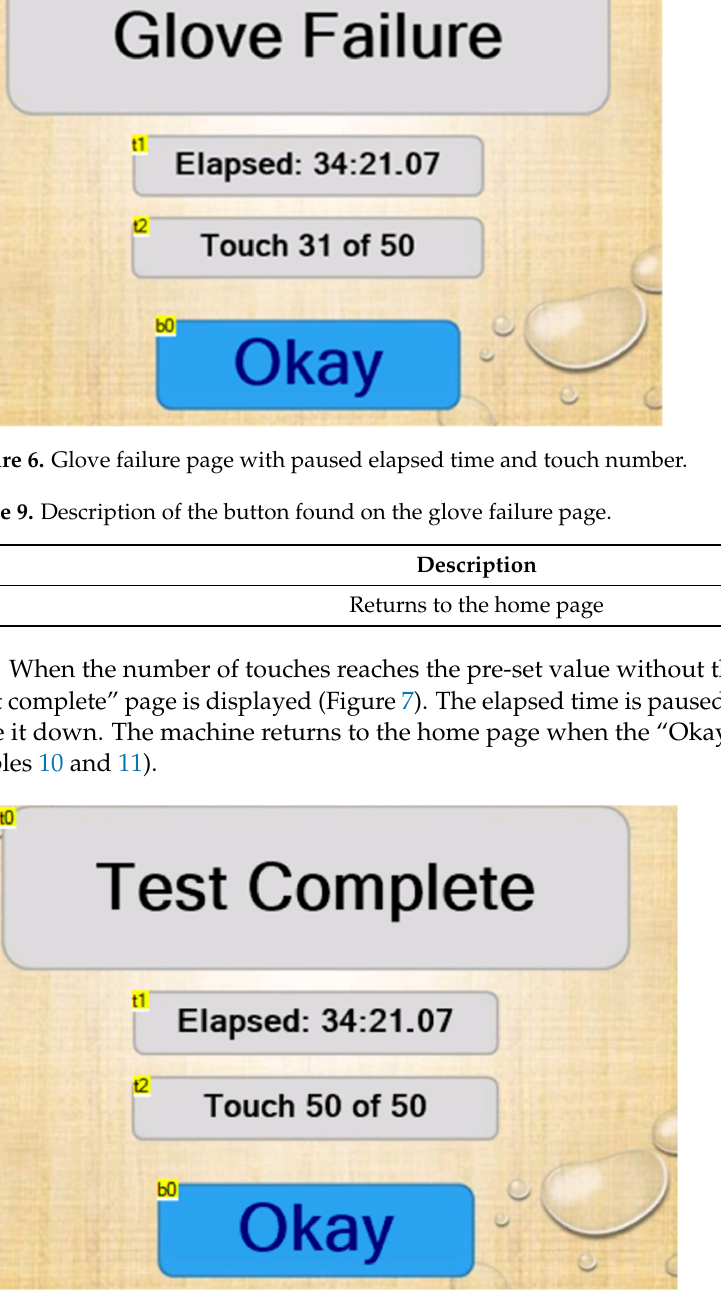
Figure 6. Glove failure page with paused elapsed time and touch number. Table 8. Description of each text field found on the glove failure page.